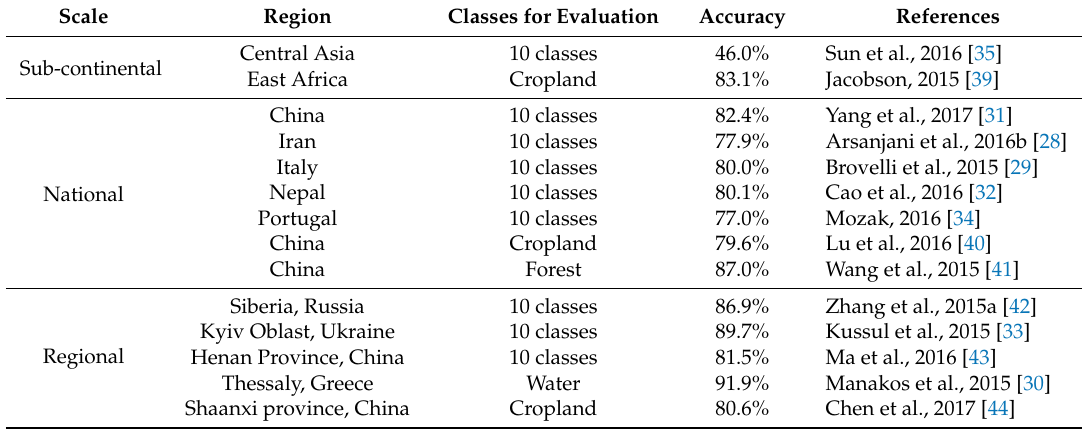
Table 2. Examples of accuracy evaluation of GlobeLand30 from published articles.